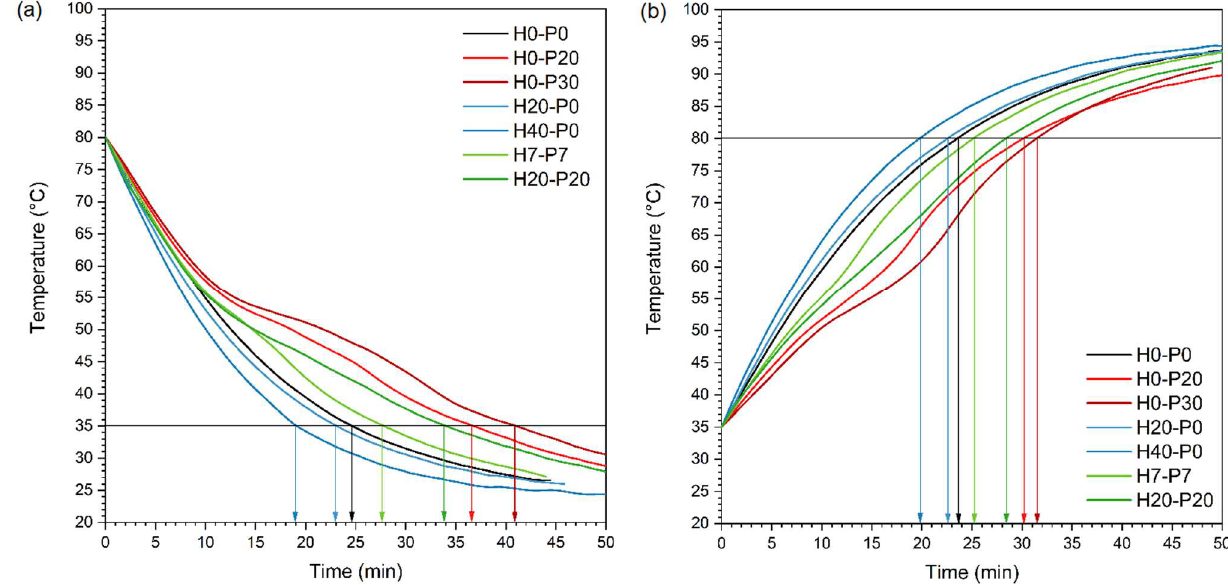
Figure 7. Temperature profiles of the analyzed samples in ( a ) cooling and ( b ) heating stages. Table 4. Results of thermal profiling tests on the prepared